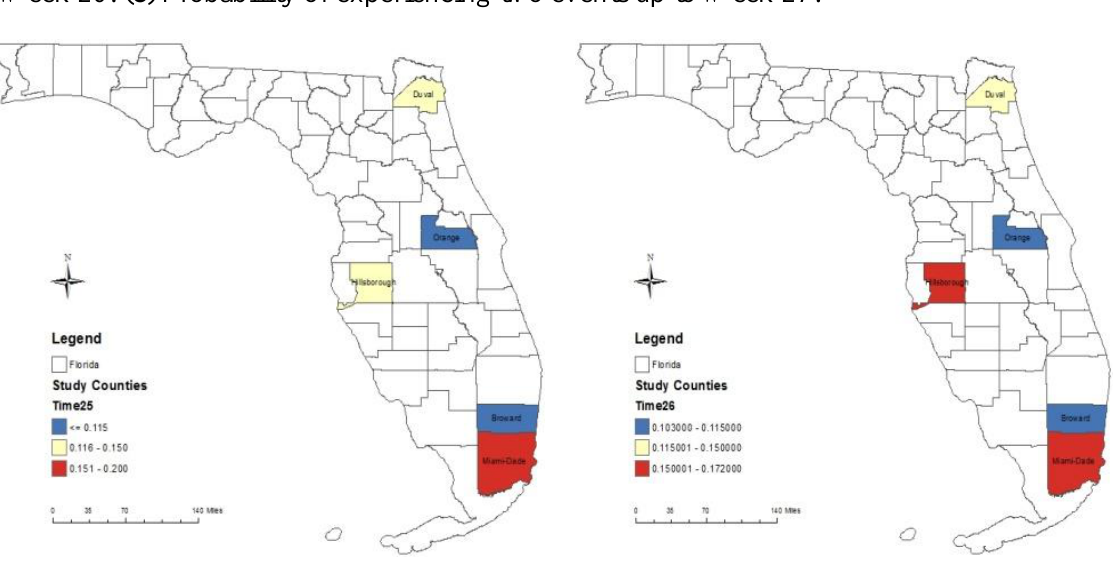
Figure 8. Application of timing in 18 selected counties in Florida. ( a ) Probability of experiencing two events up to Week 25. ( b ) Probability of experiencing two events up to Week 26. ( c ) Probability of experiencing two events up to Week